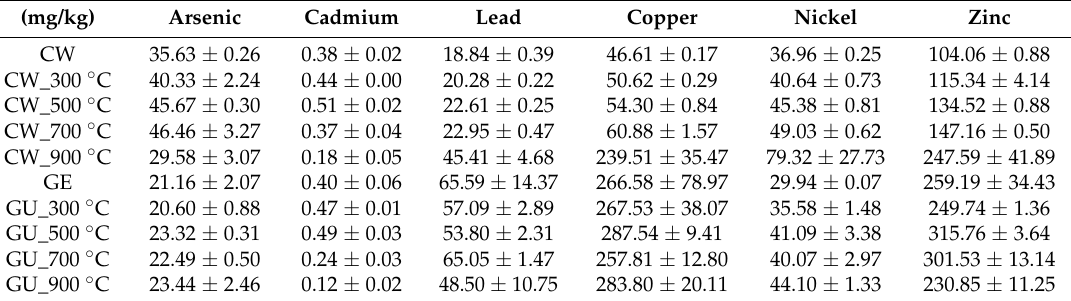
Table 6. Heavy metal contents at different pyrolysis temperatures.